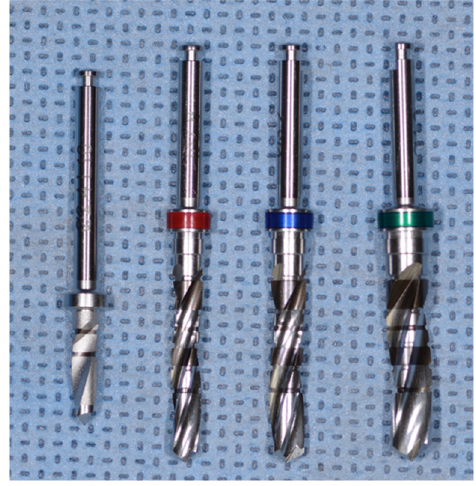
Figure 4. The MIS ® straight drills used in the study (2.4, 2.8, 3.2, and 4.0 mm.).